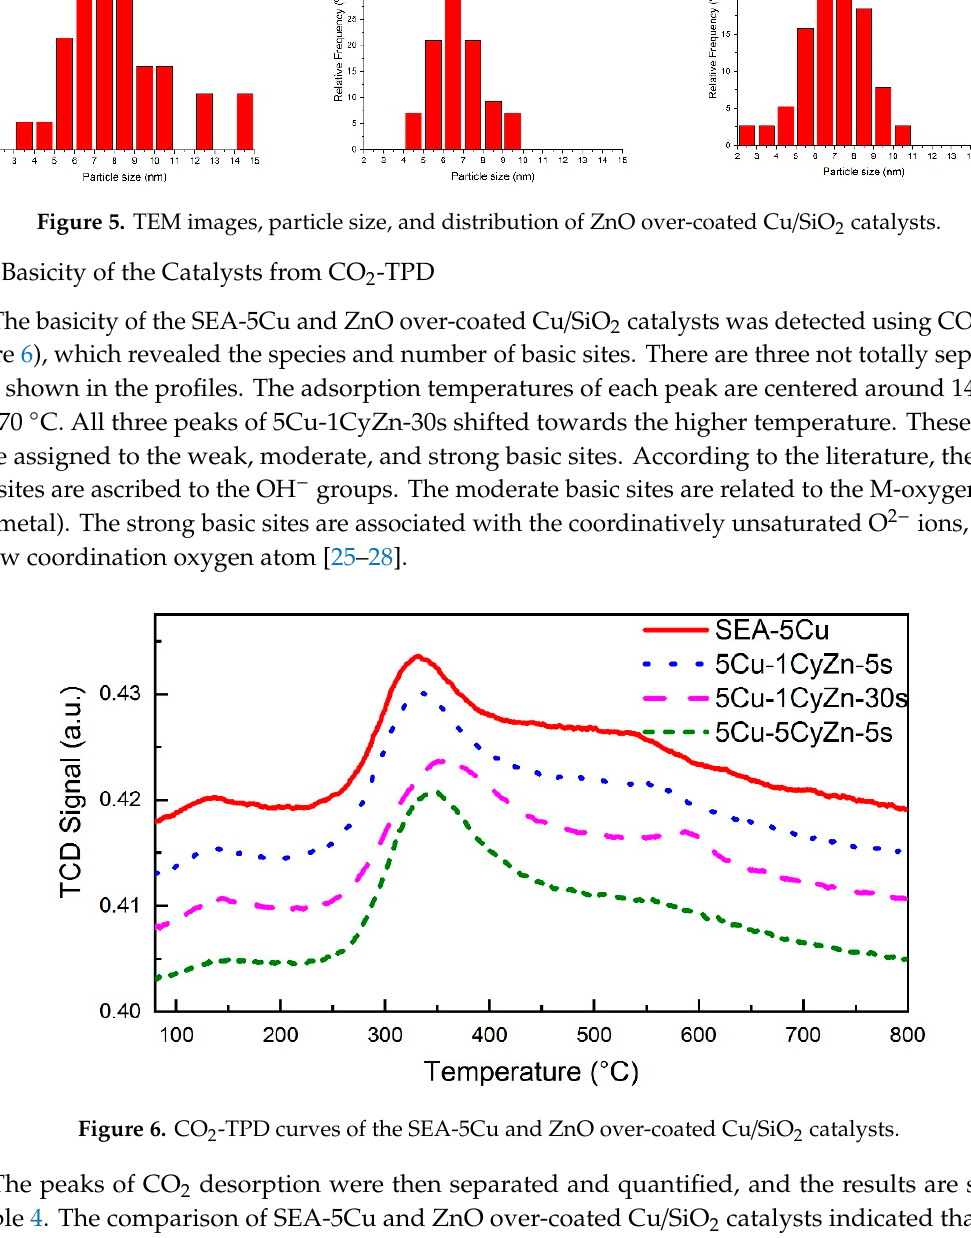
Figure 6. CO 2 -TPD curves of the SEA-5Cu and ZnO over-coated Cu/SiO 2 catalysts.